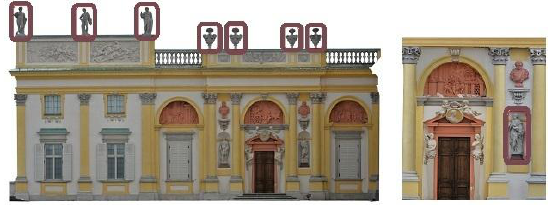
Figure 3 Fragments of orthoimages of the historical facade from TLS with marked elements acquired from the image matching